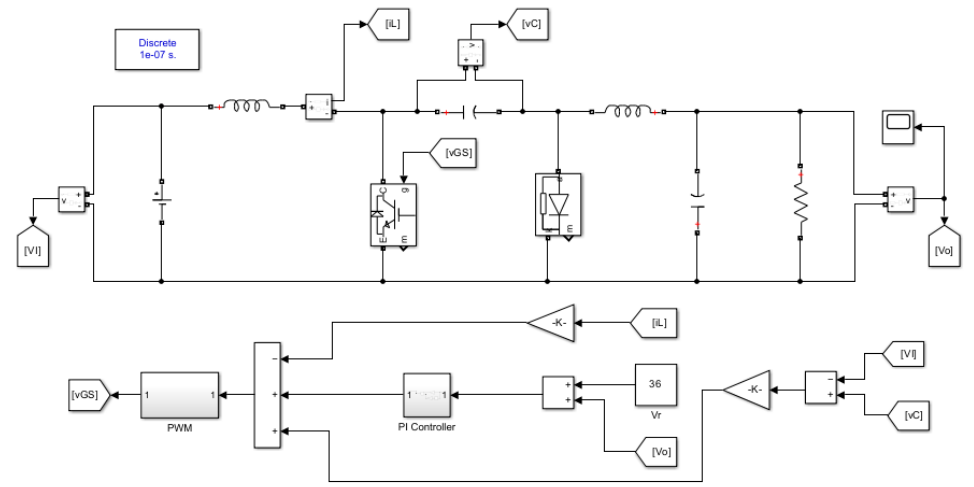
Figure 3. MATLAB/SIMULINK model of the simplified double-integral sliding-mode current control of the DC-DC Cuk converter.